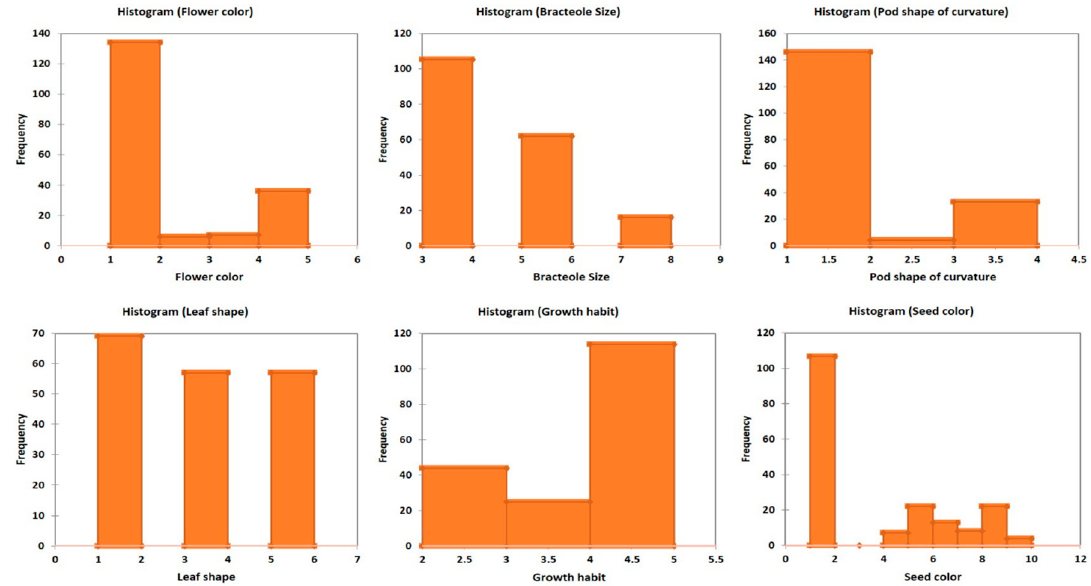
Figure 3. Frequency distribution charts of studied qualitative traits in Turkish common bean germplasm. Flower color: 1 White, 2 Light purple, 3 lilac, 4 Purple; Bracteole Size: 3 Small, 5 Medium, 7 Large; Pod shape of curvature: 1 Concave, 2 S-shaped, 3 Convex; Leaf shape: 1 Triangular, 3 Circular, 5 Quadrangular; Growth habit: 2 Indeterminate bushes, 3 prostrate, 4 Climber; Seed color: 1 White, 4 yellow, 5 beige, 6 brown, 7 dark red, 8 purple,